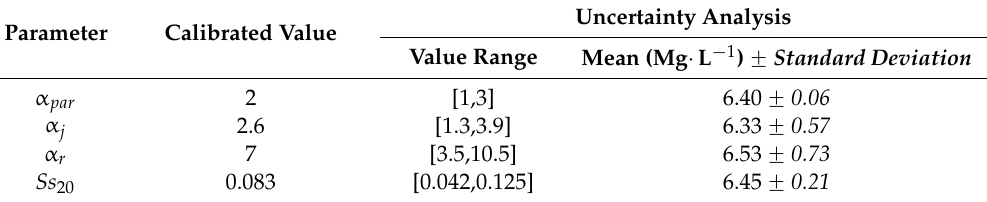
Table 1. Calibrated model parameters and parameter uncertainties. For each parameter in the uncertainty analysis, 6000 randomly chosen input values were passed through the model to obtain means and standard deviations (in italic ) of the resulting annual average of DO concentrations.